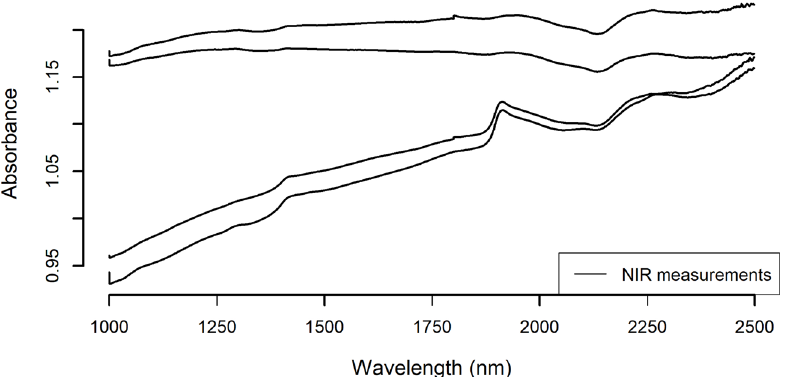
Figure 4: A number of NIR measurements collected on di ff erent points of the same artefact, represented as spectra. Each measurement is represented by one line in the above diagram, where peaks indicate overtone regions of molecular vibration. Heterogeneous material might therefore exhibit di ff ering levels of absorbance and produce slightly di ff erent sets of peaks depending on what part of the surface is measured. Image produced with R ( Version 4.1.2; R Core Team, 2021 ) and the spectrolab package ( Meireles, Schweiger, & Cavender - Bares, 2017 )